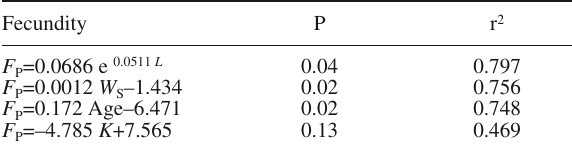
t ablE 5. – Regression analysis for the effects of total length ( L ), somatic weight ( W ), age and condition index ( K ) on potential an- S nual fecundity in ripening reared females.